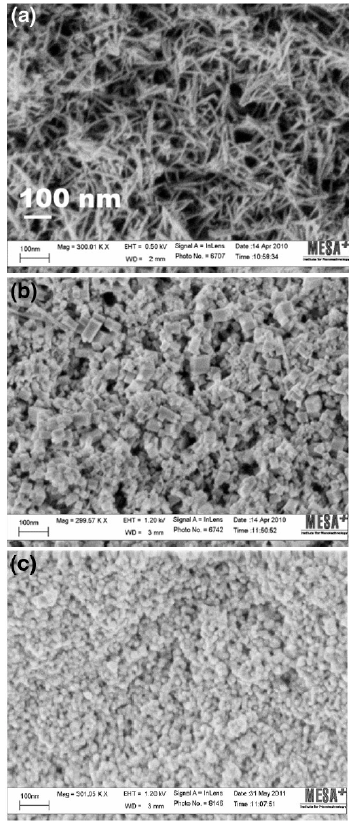
Figure 3. HRSEM images of cerium oxide nanoparticles in different morphologies; ( a ) nanorods, ( b ) nanocubes, and ( c ) nanospheres [19], used with no changes under the terms of the Creative Commons Attribution 4.0 International License (http://creativecommons.org/licenses/by/4.0/).